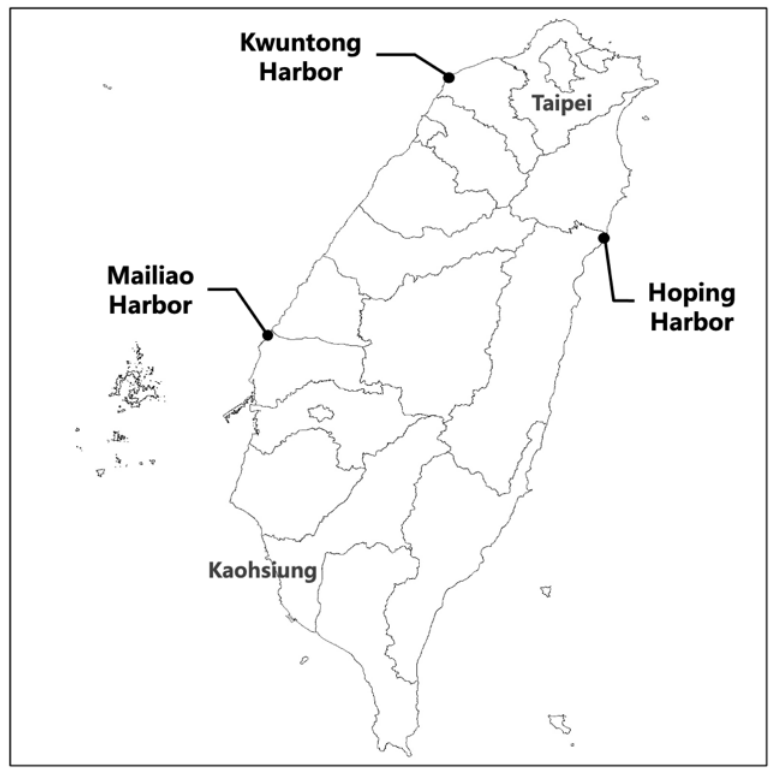
Figure 1. Location map of the exclusive industrial harbors in Taiwan.